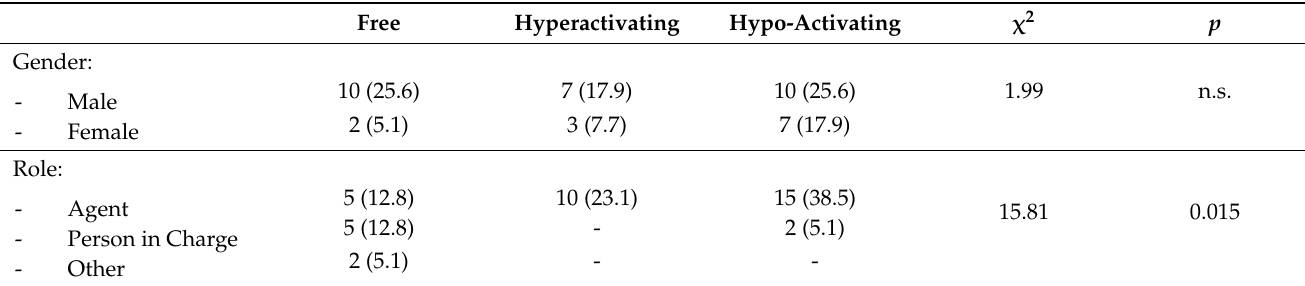
Table 4. Sociodemographic characteristics of the participants who used different strategies to cope with the trauma. Values are expressed as n (percentage) ( n = 39).